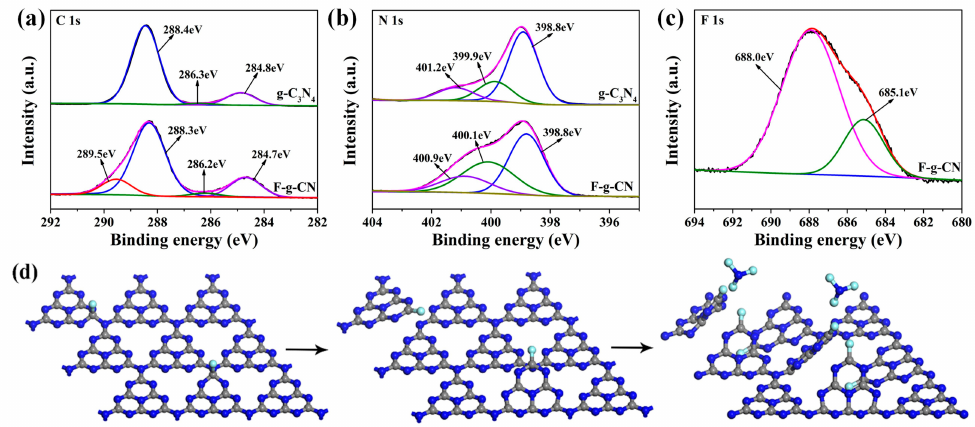
Figure 4. High-resolution XPS spectra of g-C 3 N 4 and F-g-CN: ( a ) C1s; ( b ) N1s; ( c ) F1s. ( d ) Schematic diagram of the g-C 3 N 4 fluorination process. The blue, gray and cyan circles represent nitrogen, carbon and fluorine atoms,